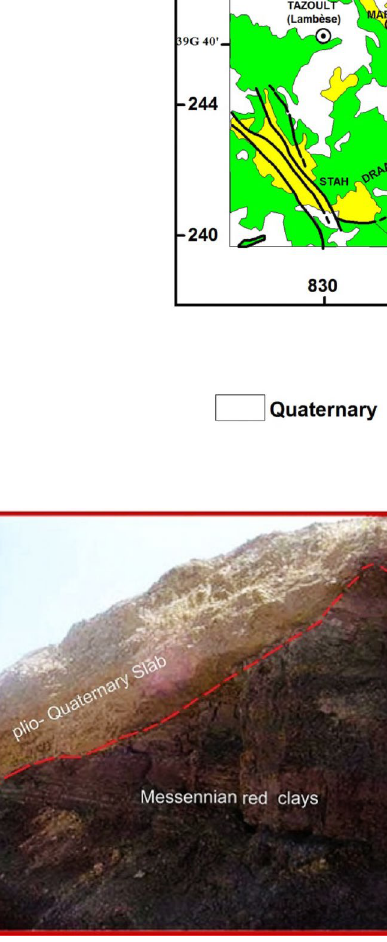
Fig. 3 Messenian red clays enclosed by a Plio-Quaternary